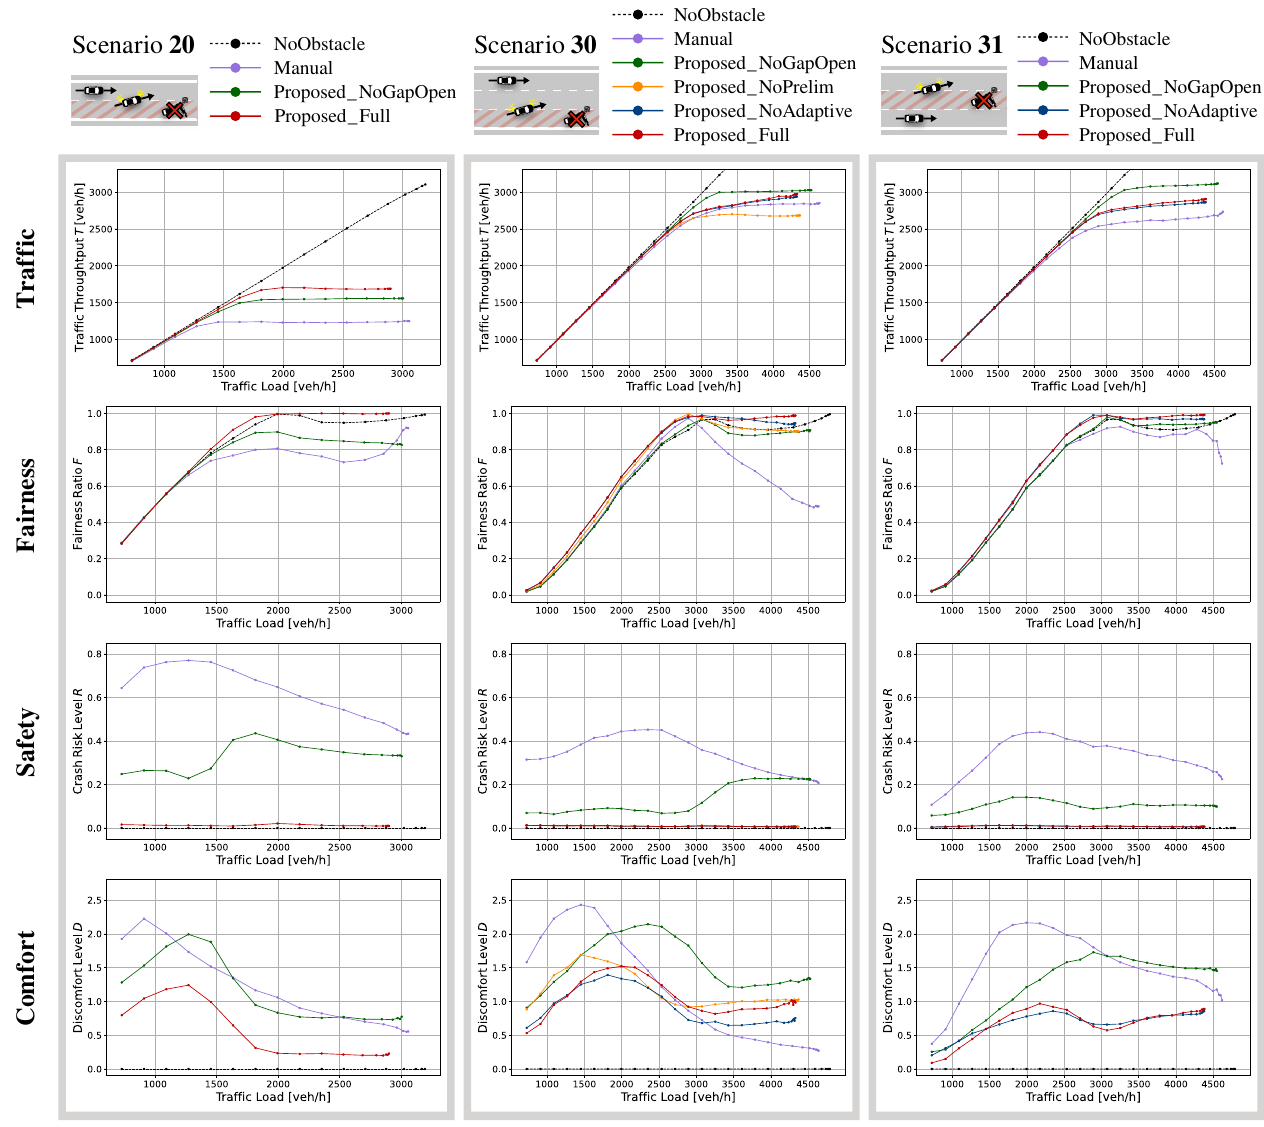
Figure 9. Simulation results for each vehicle behavior model under different traffic